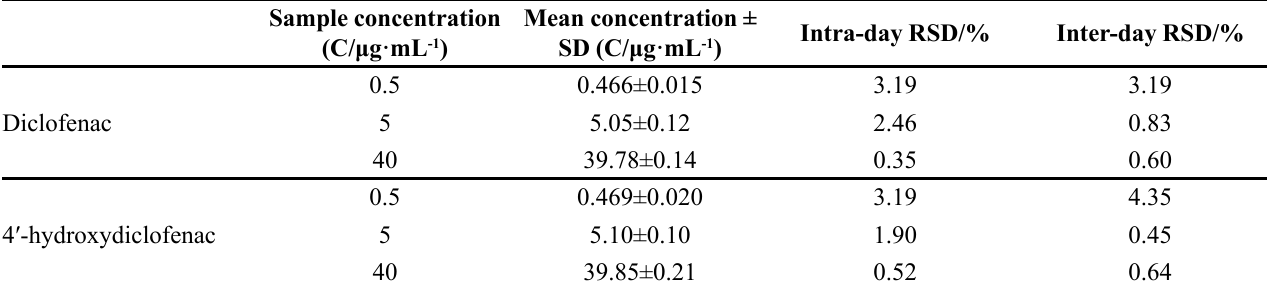
TABLE I - Intra and Inter-day precision of diclofenac and 4′-hydroxydiclofenac (n=3)